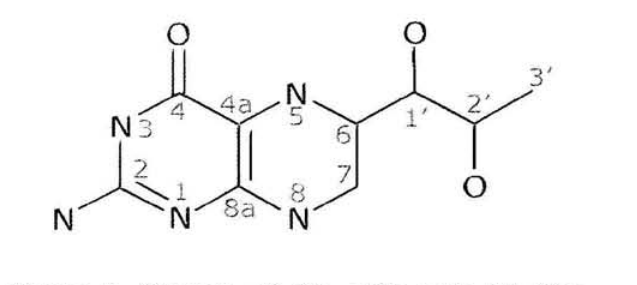
Ν Ν Figure 1. Structure of BH 4 with atom labelling (hydrogens not shown). phenylalanine (Phe254) and the N3 and the amino group at C2 hydrogen bonds with the carboxylic group of a conserved glutamate residue (Glu286). In the crys-